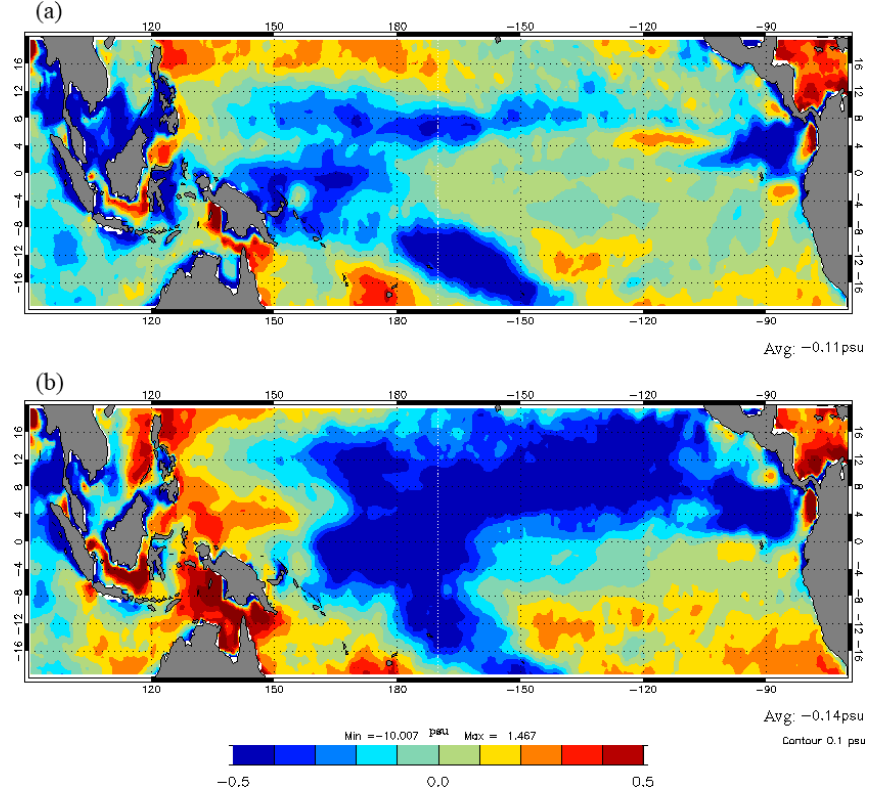
Figure 1. SSS anomalies (practical salinity scale, pss) in 2014 (a) and 2015 (b) mean salinity difference (model (control run) – the World Ocean Atlas climatology (WOA)